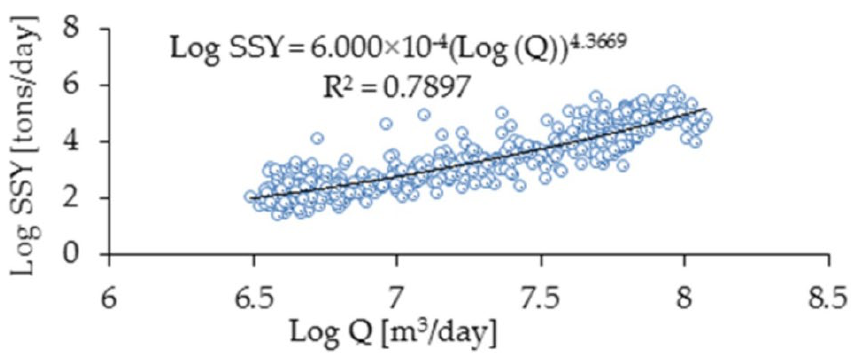
Figure 10. Sediment rating curve plot.